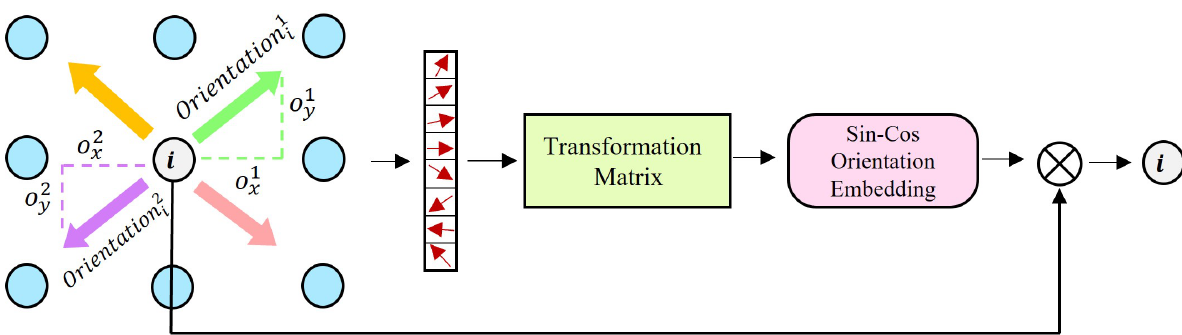
Figure 4. Geometric Orientation Embedding. The eight orientations around the keypoint are calcu- lated from the offset map, and the maximum value is taken as the main orientations of the local feature. Then the transformation matrix is obtained by the principal orientation transformation. The transfor- mation matrix is encoded as sine-cosine information, which is embedded in the high-dimensional features along with the response